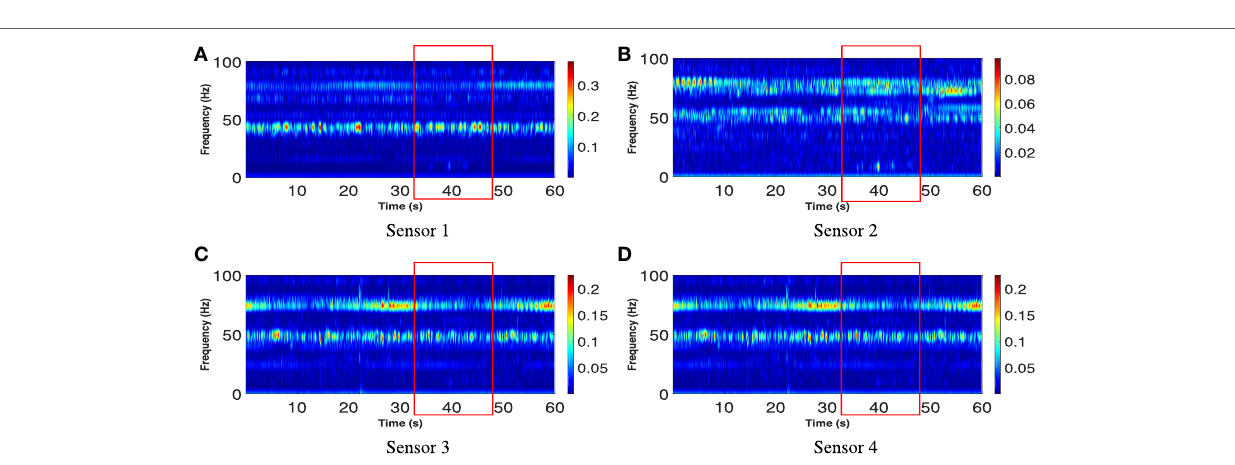
FIGURE 5 | Short-time Fourier Transform (STFT) of vibration signals shown in Figure 4 . The red boxes show the time duration of train passing. Similar to the vibration signal, the train event is not obviously visible. (A) Sensor 1. (B) Sensor 2. (C) Sensor 3. (D) Sensor 4.